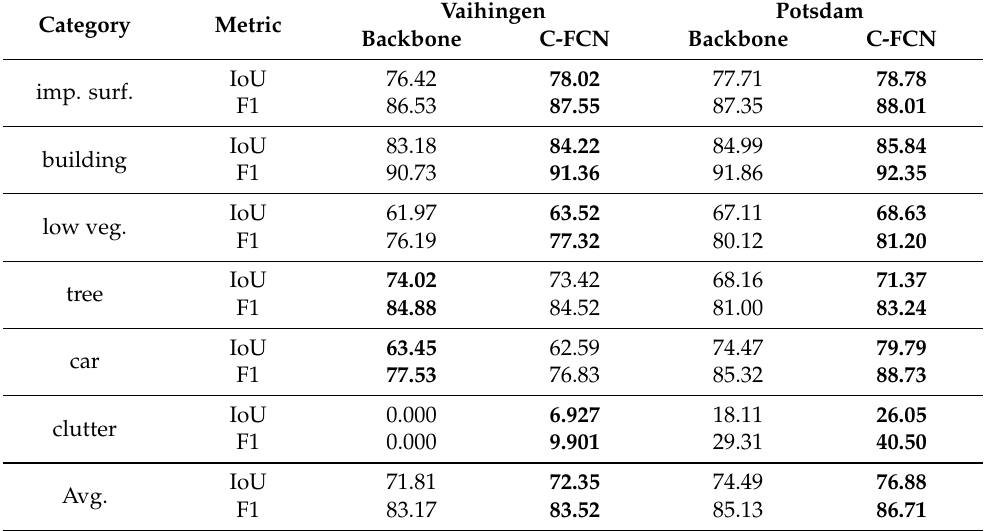
Table 2. Performances of the class-wise network design measured by mean F1-score (%) and mean IoU (%) of all test samples.